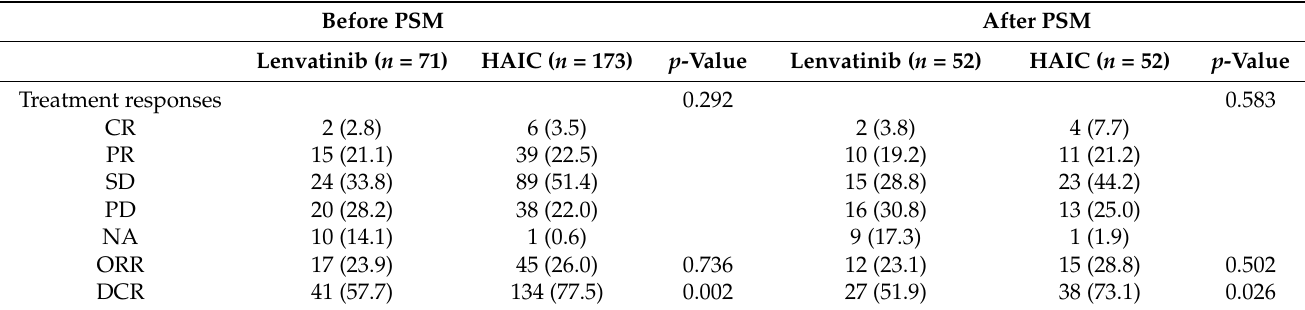
Table 2. Treatment responses before and after